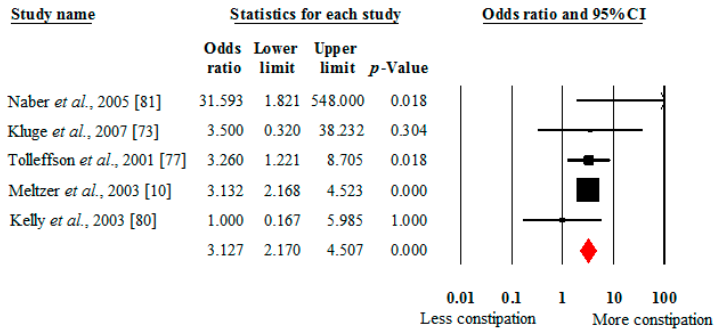
Figure 3. Odds of constipation in people taking clozapine versus olanzapine.